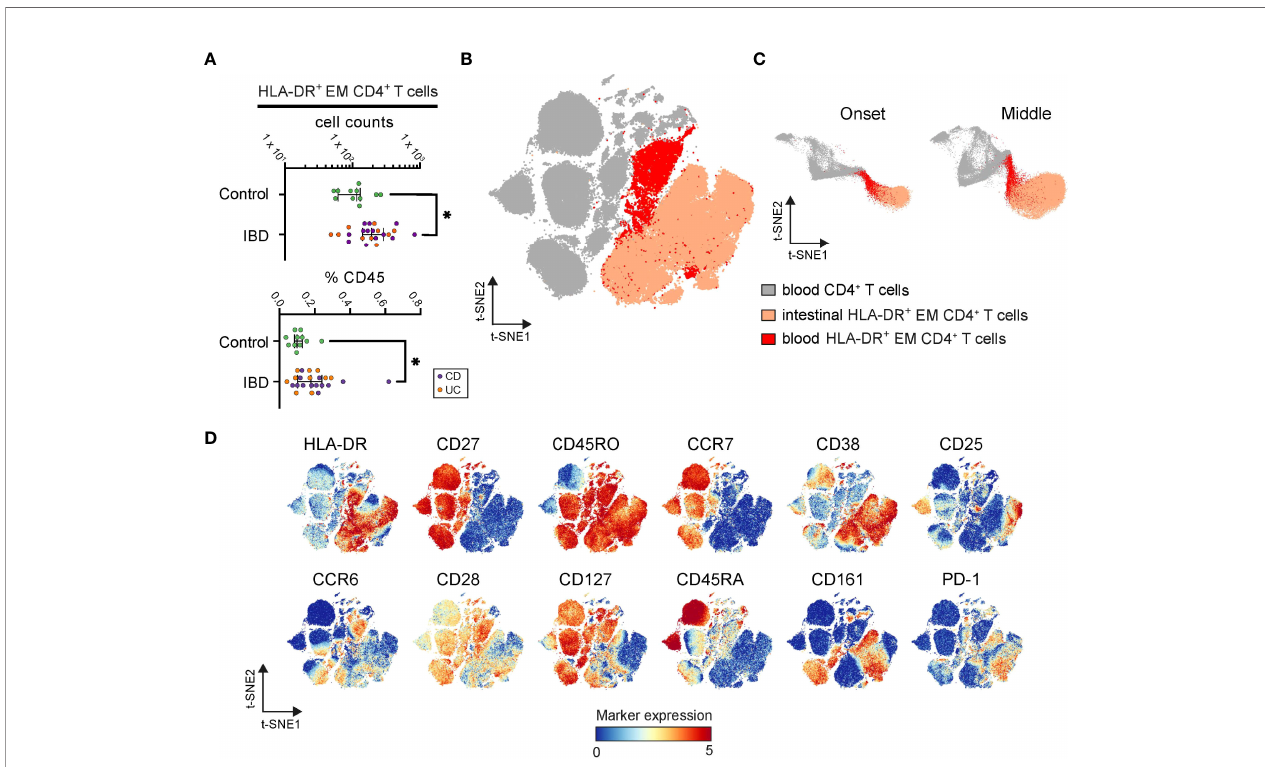
FIGURE 5 | Identi fi cation of in fl amed instestine-associated CD4 + T cells in blood. (A) Graphs show frequencies of blood CD4 + T cells linked to the intestinal HLA-DR + EM phenotype in each PBMC sample. Bars indicate the median with interquartile range. *p ≤ 0.05, Mann-Whitney test. (B) t-SNE embedding of blood CD4 + T cells (grey) and classi fi ed blood CD4 + T cells linked to the intestinal HLA-DR + EM phenotype (red) from 34 PBMC samples, and the HLA-DR + CD4 + EM T cells (apricot) from 99 intestine samples. (C) t-SNE embedding at the onset and the middle of the computation. (D) t-SNE embedding colored for the expression values of the indicated